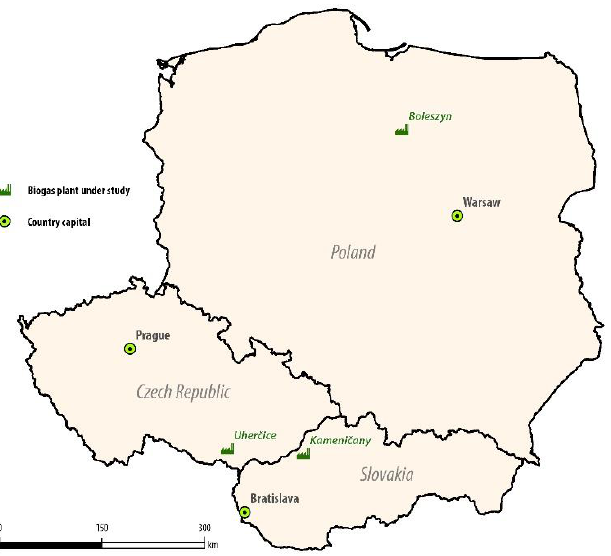
Figure 1. Location of the three studied AD plants in Slovakia, Poland, and the Czech Republic. The Boleszyn AD plant is among the largest AD plants in Poland (3.6 Mwe). It con-